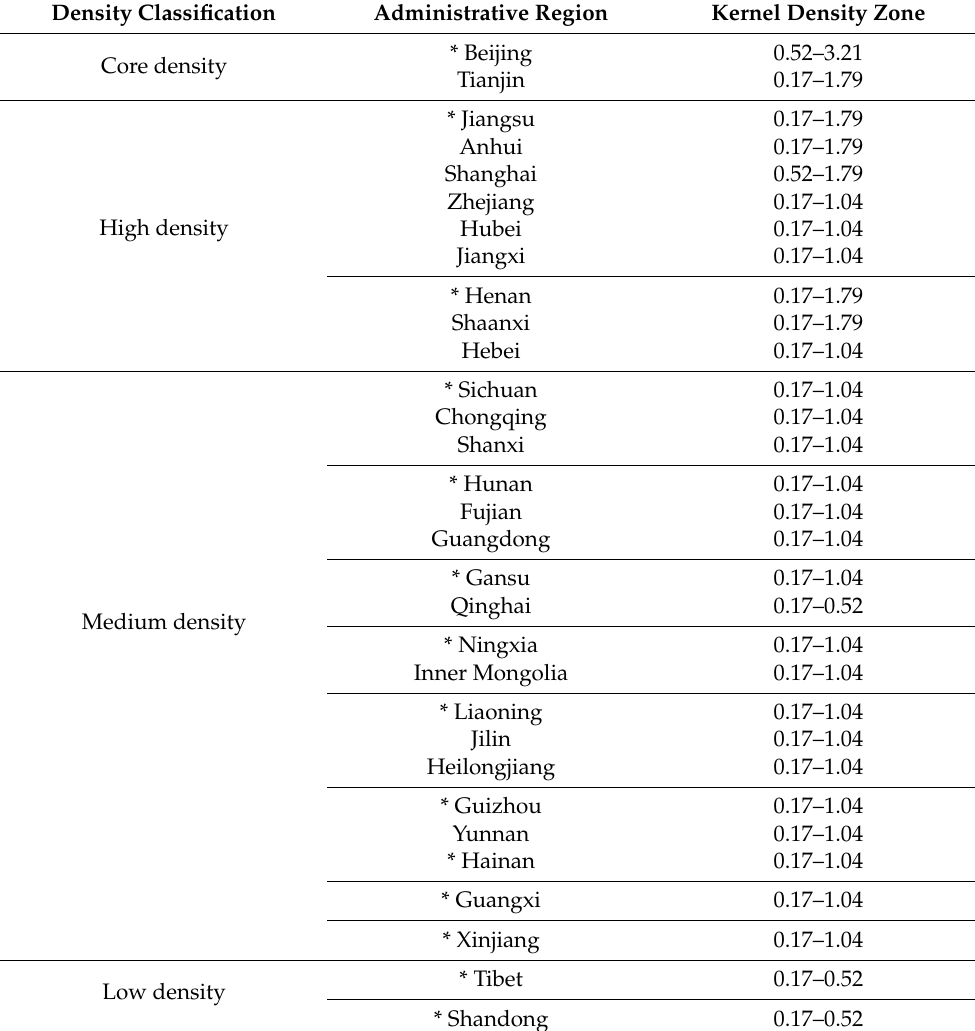
Table 2. Kernel density analysis of NRTTC.